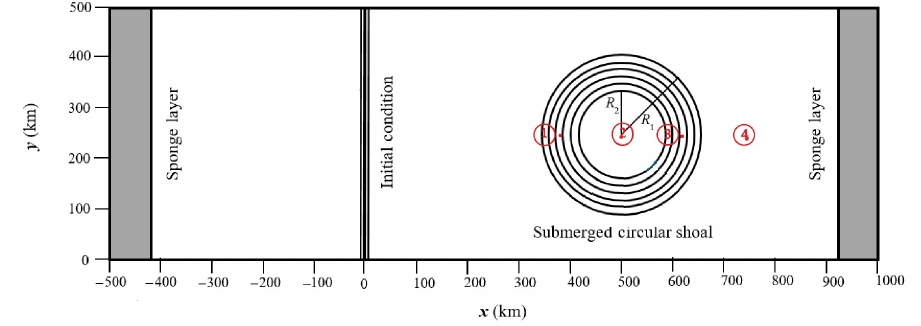
Figure 6. Submerged circular shoal, wave gauges and initial condition